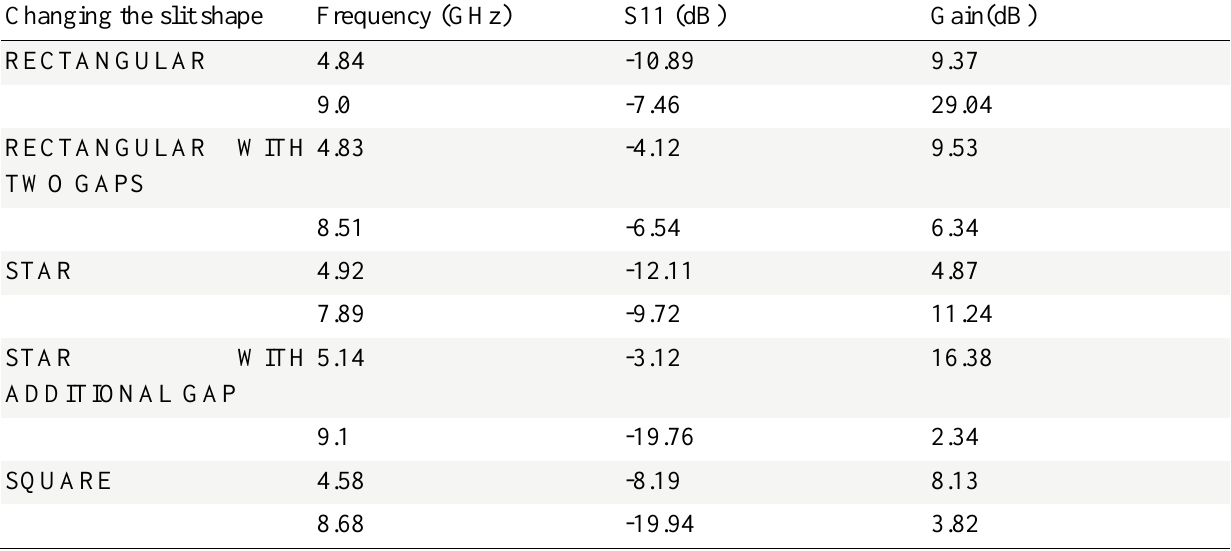
Table 9. Changing dielectric thickness on different